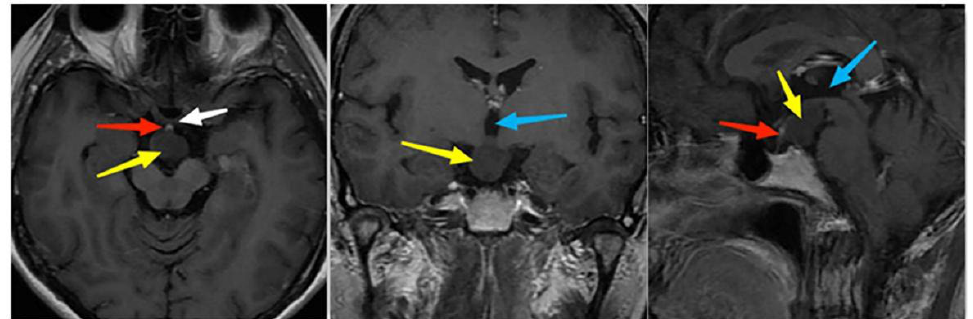
Figure 1. MRI images. Preoperative MRI-enhanced T1 images show a slightly strengthened tumor located in the suprasellar region, behind the optic chiasm, and below the third ventricle; the pituitary gland and pituitary stalk are significantly enhanced (yellow arrows point to the tumor, white arrow points to the optic chiasm, red arrows point to the pituitary stalk, and blue arrows point to the third ventricle).